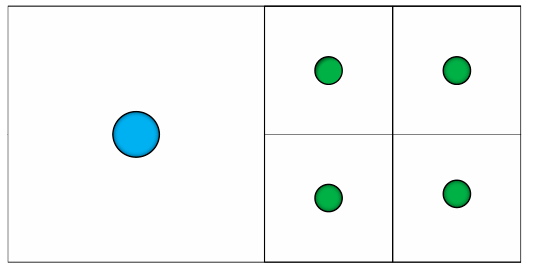
Figure 1. Center point format.